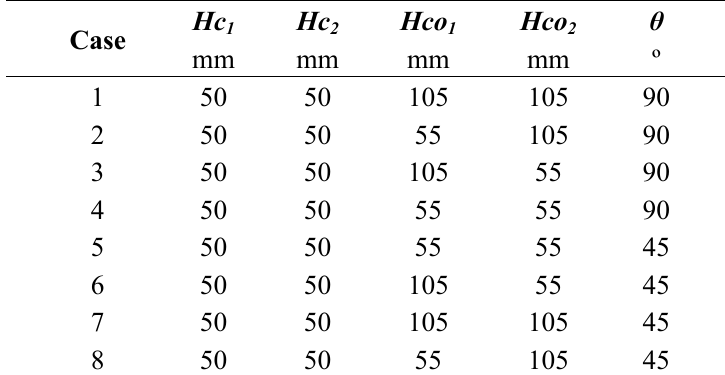
Table 1. Experimental setup of different cases (cases 1–8). Hc windward and leeward opening size, respectively; Hco center of windward and leeward opening to the floor, respectively. θ is the angle between the direction of wind and the roof ridge of the model